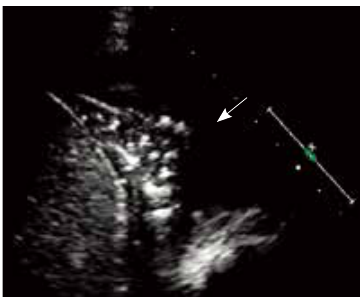
Figure 4 More fluid exudation or leaking out cause pleural effusion (arrow). Pulmonary effusion often appears in the gravity dependent area, where consolidation of lung tissue can be seen in the liquid dark area with hyper echo of unabsorbed